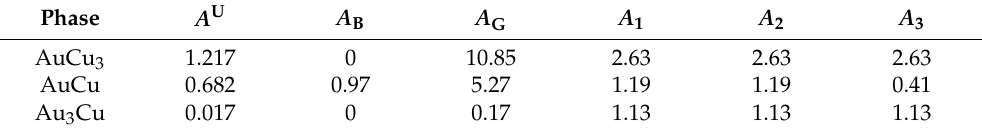
Table 4. Calculated anisotropic index of Au–Cu